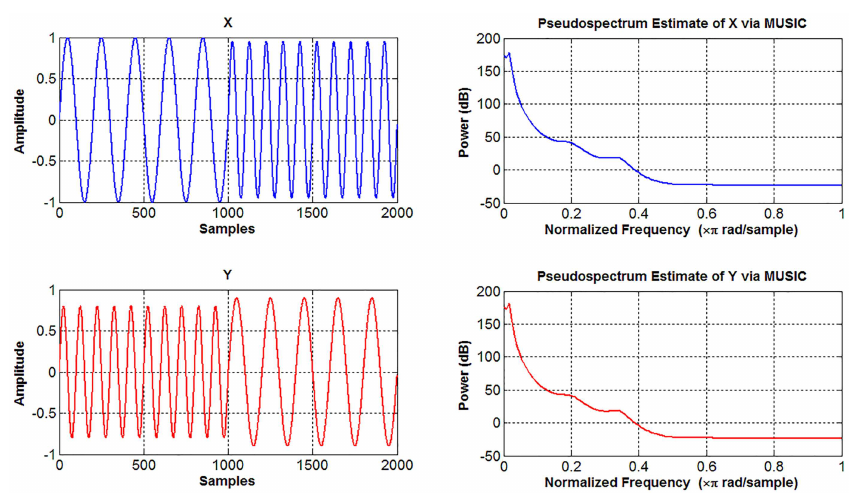
Fig 5. Display of two different signals representedin the time-amplitude and frequency-amplitude